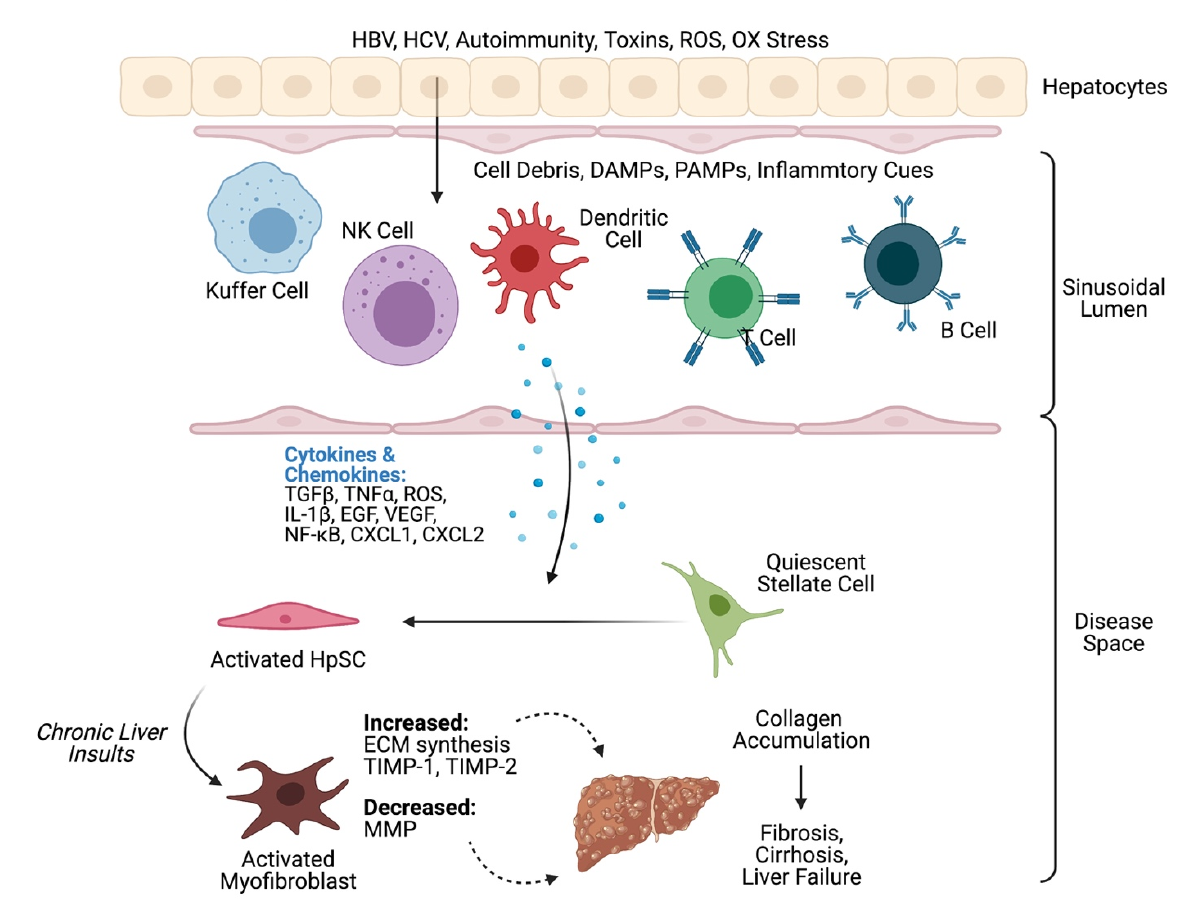
Figure 1. Original schematic depicting the immunological mechanism behind liver fibrosis, cirrhosis, and failure. A sum- mary schematic of hepatic stellate cell (HpSC)-initiated extracellular matrxi (ECM) deposition, where imbalanced tissue inhibitors of metalloproteinase (TIMP)/matrix metalloproteinase (MMP) ratios lead to less proteolytic activity and increased collagen synthesis. HBV: hepatitis B virus, HCV: hepatitis C virus, DAMP: damage-associated molecular pattern, PAMP: pathogen-associated molecular pattern, NK: natural killer, TGF- β : transforming growth factor β , TNF α : tumor necrosis factor-alpha, ROS: reactive oxygen species, IL: interleukin, EGF: epidermal growth factor, VEGF: vascular endothelial growth factor, NF- κ B: nuclear factor-kappa B, CXCL: chemokine (C-X-C motif) ligand. Original schematic was created with BioRender.com.